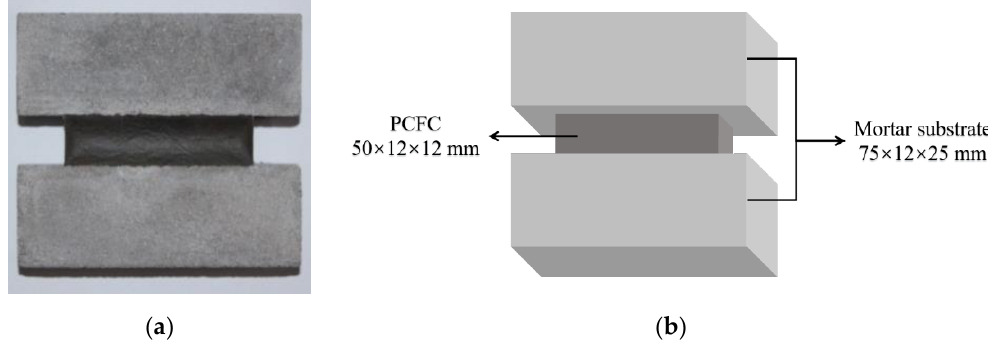
Figure 1. ( a ) The PCFC specimen for fixed elongation and tensile test. ( b ) Schematic diagram of the PCFC specimen.